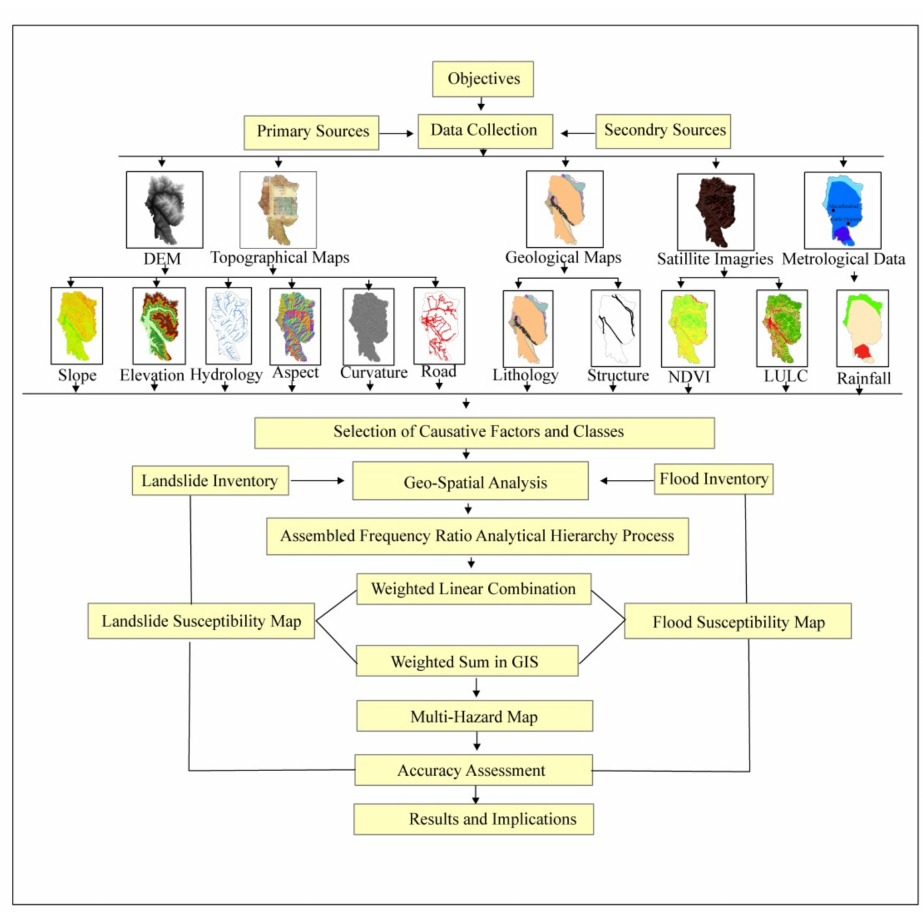
Figure 2. Methodological flow chart for the multi-hazard susceptibility